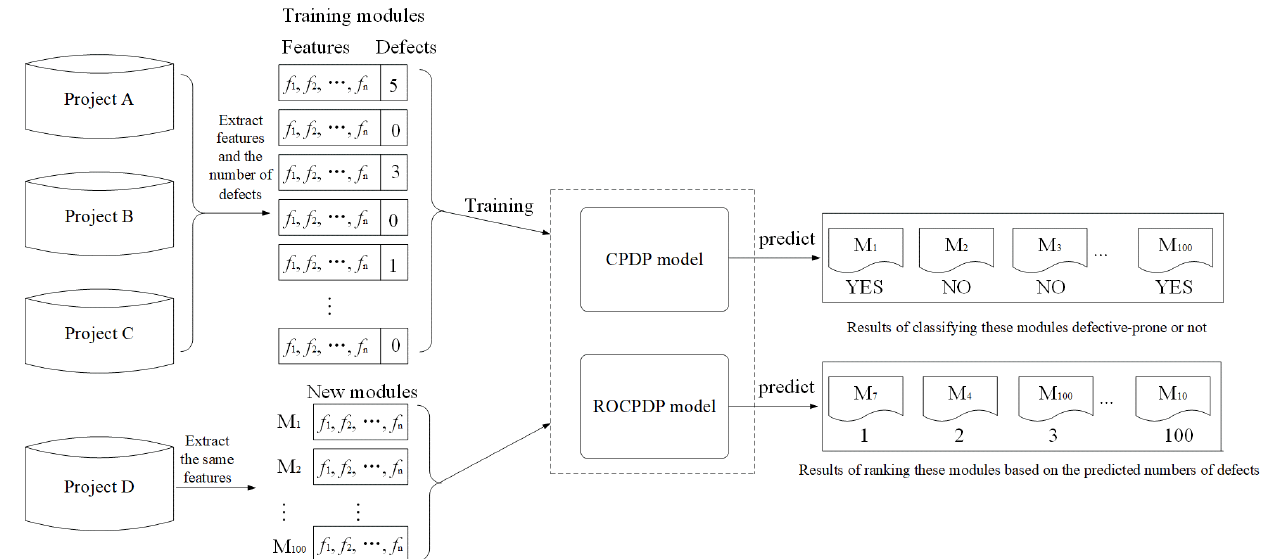
Figure 1. The difference between a CPDP model and a ROCPDP